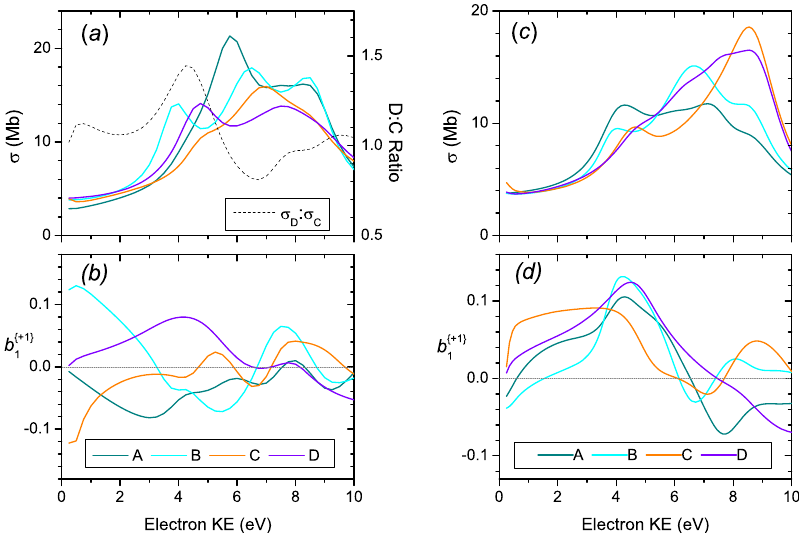
Fig. 6 CMS-X α calculations on L -proline for photoionization of conformers A – D. a and b HOMO orbital; c and d HOMO-1 orbital.The top panels ( a and c ) show partial cross-sections, σ ; the bottom panels ( b and d ) display chiral asymmetry parameters b 1 { + 1} . Panel a for the HOMO photoionization also shows the D:C conformer cross-section ratio as a dashed